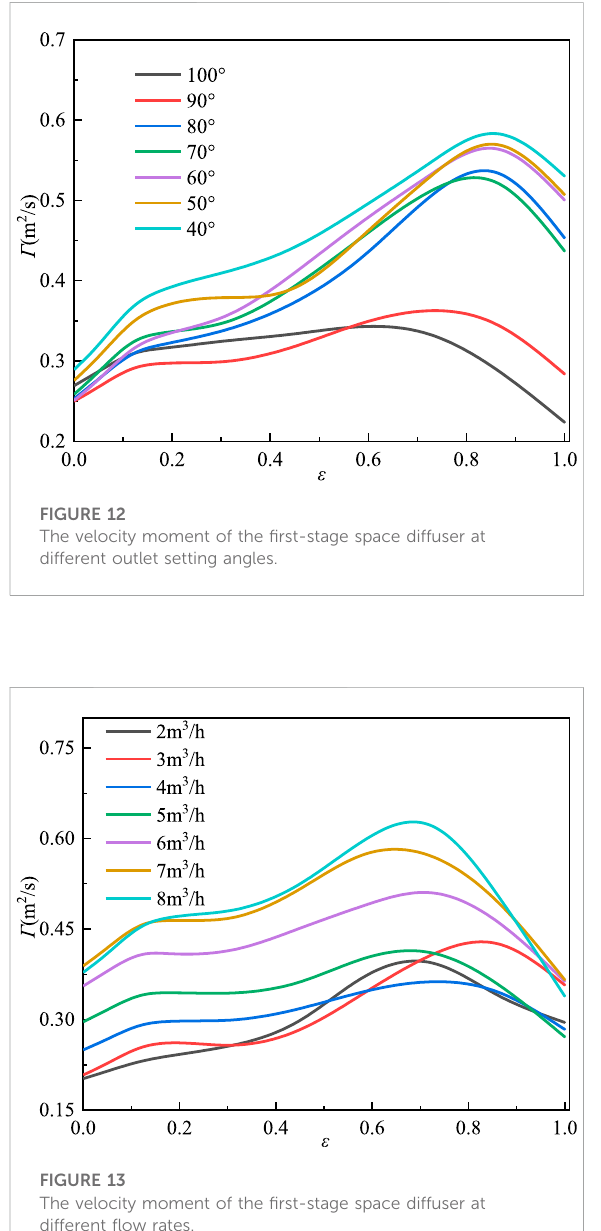
FIGURE 13 The velocity moment of the fi rst-stage space diffuser at different fl ow